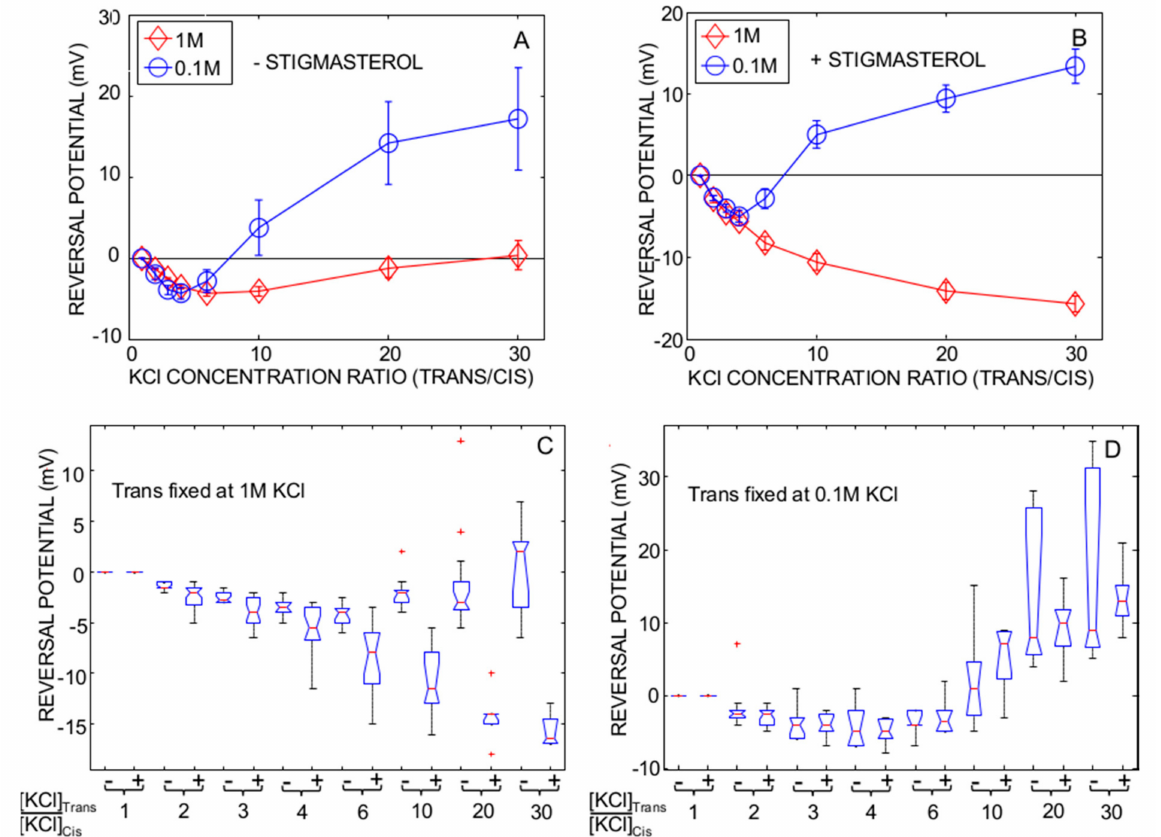
Figure 2. Changes in the reversal potential with KCl concentration ratio (Trans/Cis). ( A , B ), the ion concentration in the Trans compartment was fixed at either 1 M (red diamond) or 0.1 M (blue circle). To generate a given concentration ratio (2, 3, 4, 6, 10, 20 and 30) between the Trans and Cis compartments, the latter was perfused with low concentration KCl solutions. The solutions were buffered at pH 7.5 with 10 mM HEPES-KOH. The experiments were performed in the absence (( A ), number of replicates: 7–19) or in the presence of 10% stigmasterol (( B ), number of replicates: 5–28) in the membrane. ( C , D ), one-way ANOVA for the effect of stigmasterol with either high KCl concentration ( C ) or low KCl concentration ( D ) in the Trans compartment. The reversal potentials was measured in the absence ( - ) or in the presence ( + ) of stigmasterol at different KCl concentration ratio. ( p < 0.001). A red cross indicates